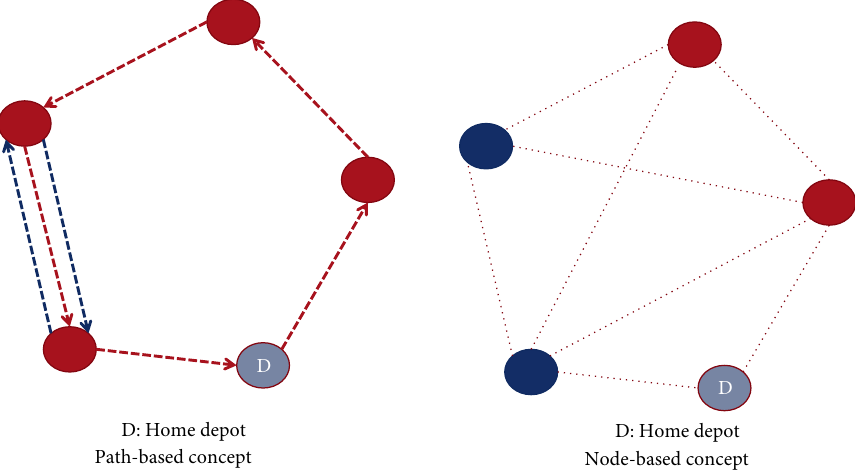
Figure 5: Path-based and node-based